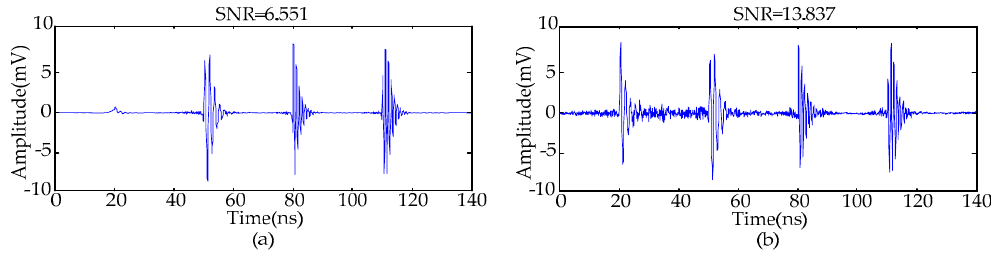
Figure 9. De-noised PD signals employing SVD when ( a ) k = 3; and ( b ) k = 5.